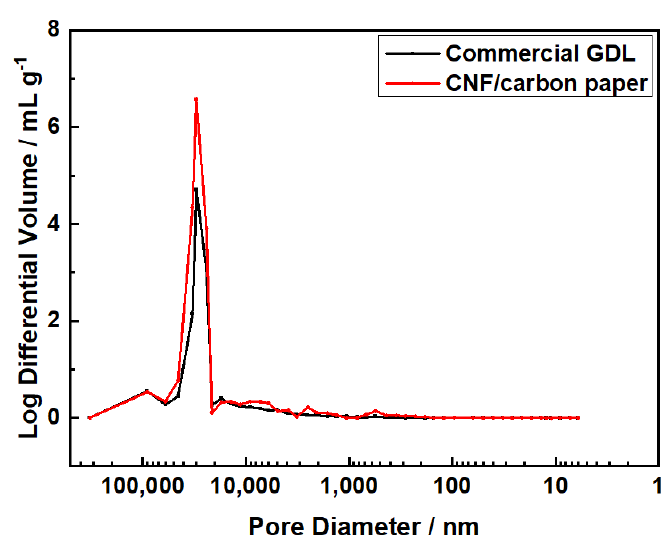
Figure 2. The pore size distribution of hydrophobic commercial carbon paper and CNF/carbon pa-